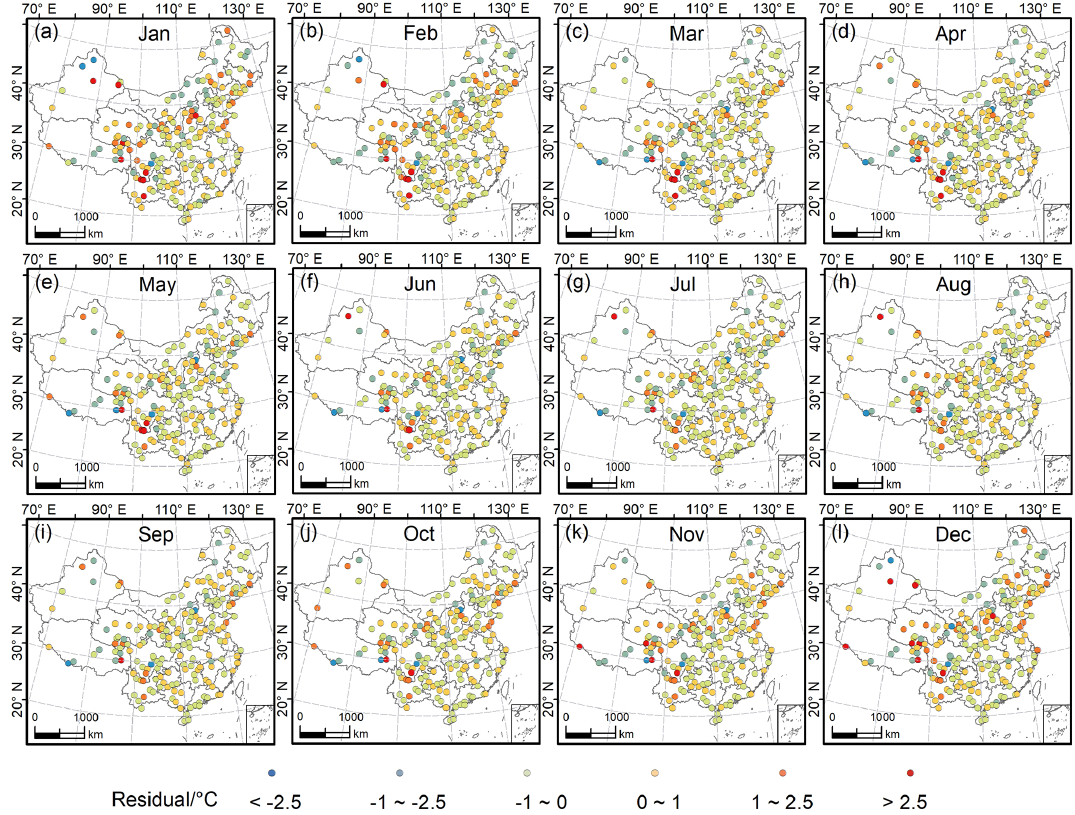
Figure 5. Spatial distribution of residuals between the observed Tmean and the predicted Tmean by GPR for the test meteorological stations for each month. Note that the exhibited residuals are the average residual of 70 years (1951–2020) for each